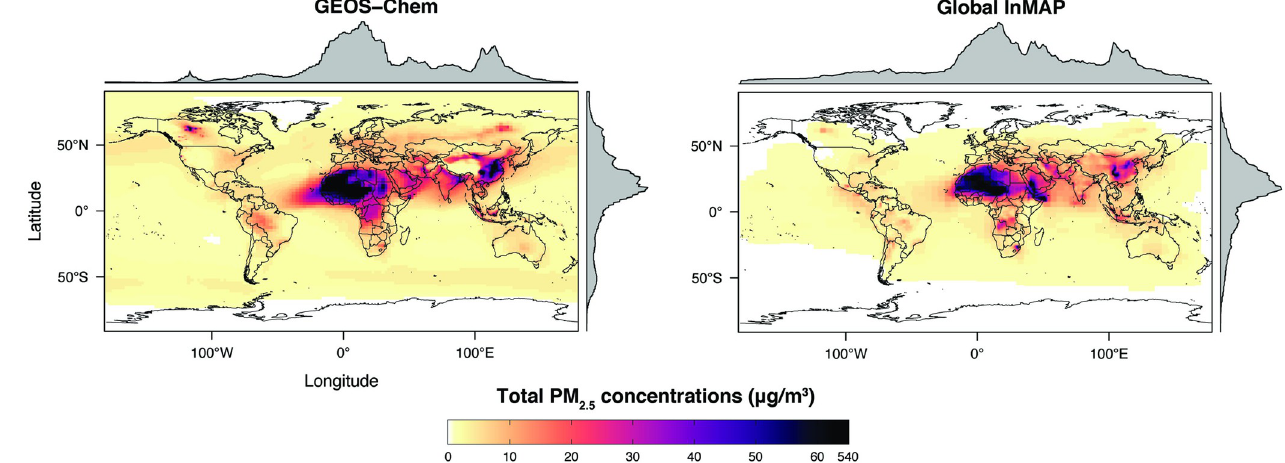
Fig 1. Annual-average ground-level total PM 2.5 concentrations from the Global InMAP and GEOS-Chem simulations for year 2016.